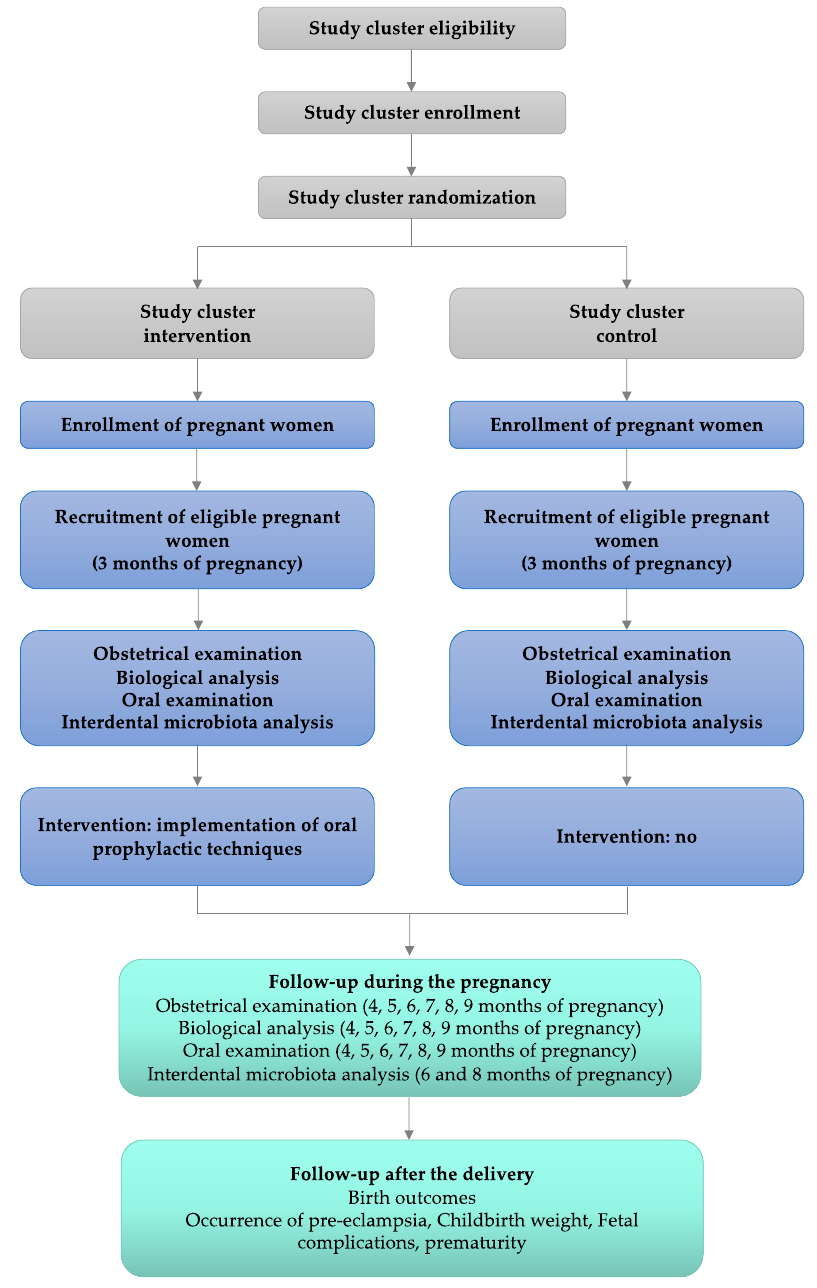
Figure 1. Flow chart